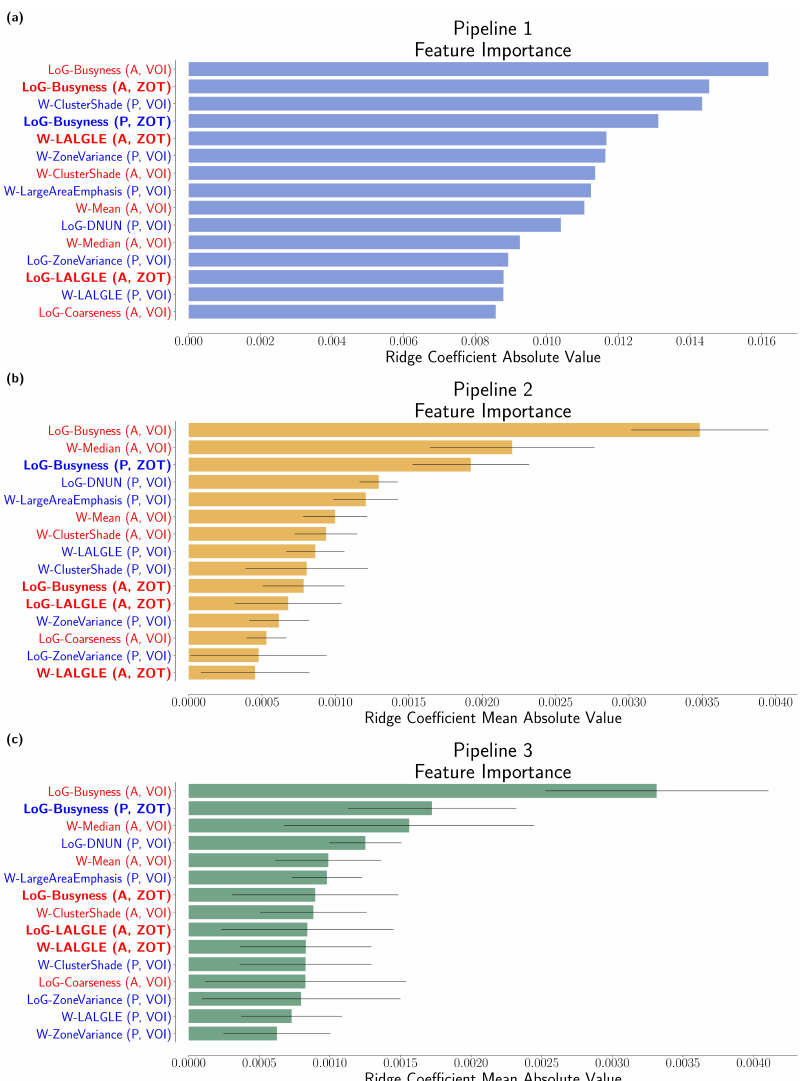
Figure 2. The importance of the 15 features selected according to the absolute value of the ridge coefficients. For each feature selected, it is reported whether it belonged to the original image (O), wavelet (W), or Laplacian of Gaussian (LoG). Moreover, whether they were computed from the CECT in the arterial (A) or the portal (P) phase is specified as the tumor (VOI) or zone of transition (ZOT) volumes. The features from the arterial phase, the portal phase, and the ZOT volume are highlighted in red, blue, and bold, respectively. ( a ) Absolute values of the ridge coefficients for the 15 selected features by Pipeline 1, i.e., computed considering the entire dataset. ( b ) The mean and standard deviation of the absolute values of the ridge coefficients for the 15 most-frequent features selected by Pipeline 2. ( c ) The mean and standard deviation of the absolute values of the ridge coefficient for the 15 most-frequent features selected by Pipeline